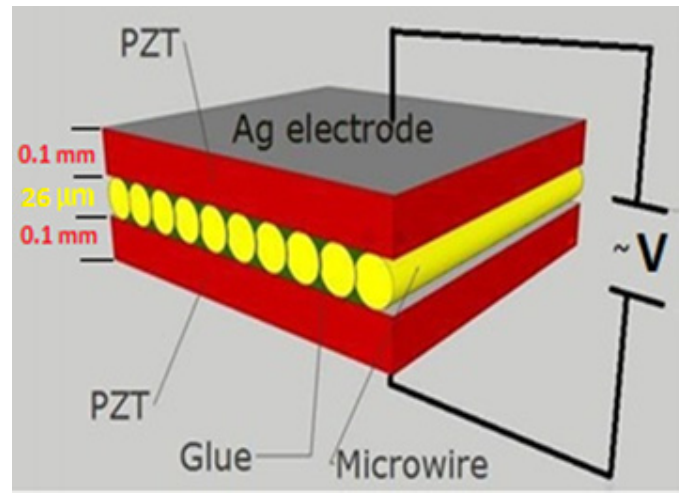
Figure 1. Sketch of the structure of magnetoelectric (ME) composite with microwires.